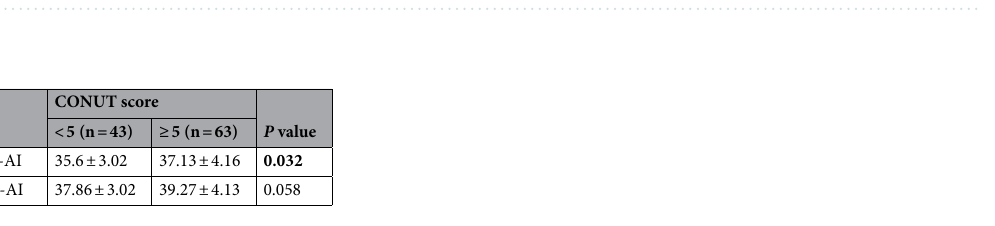
Table 6. Analysis of the significant difference between CONUT score and patient psychology status.